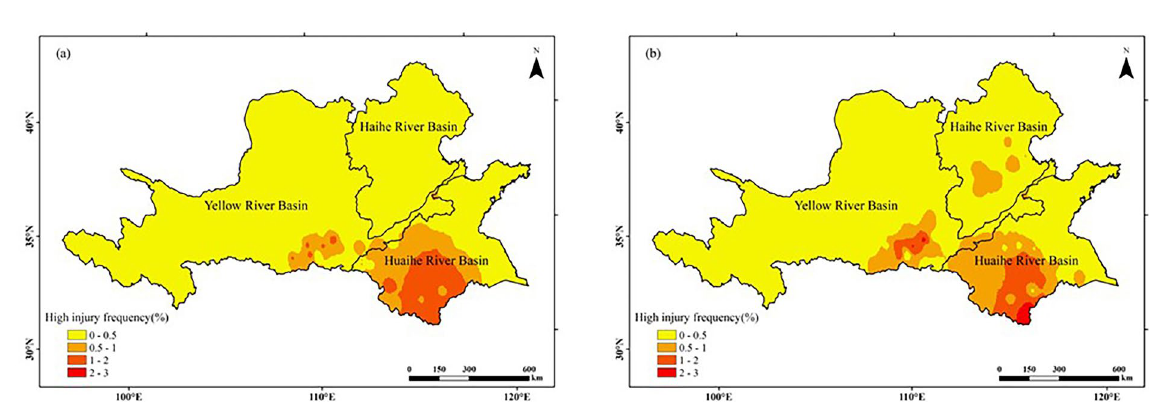
Figure 12. Chilling injury frequency of peanut growing season in Huang-Huai-Hai region in two climatic years: ( a ) 1960–1989; ( b ) 1990–2019. The figure was made in the ArcGIS 10.2 platform (https:// www. esri. com/ en- us/ home).